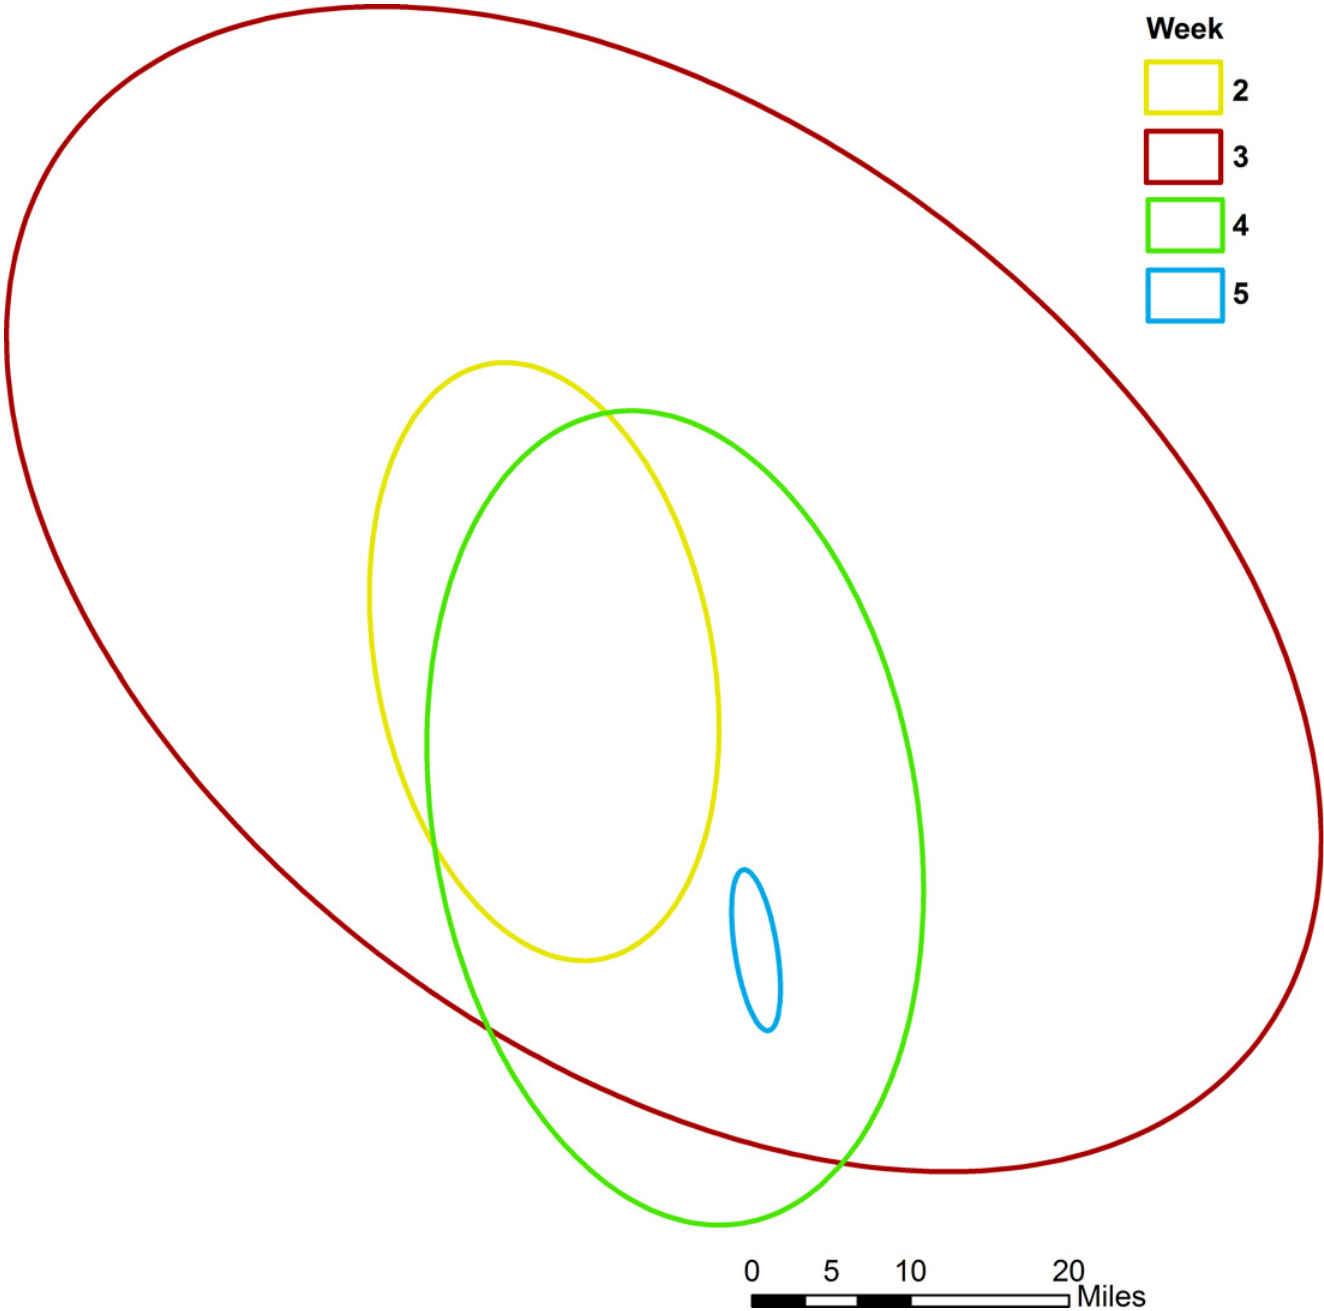
Fig 4. Weekly directional ellipses showing an overall north-south orientation of virus spread. No ellipse was generated for the first week because only one positive was reported that week. During the third week, an outlying positive in the southeastern extent of the outbreak caused a northwest to southeast